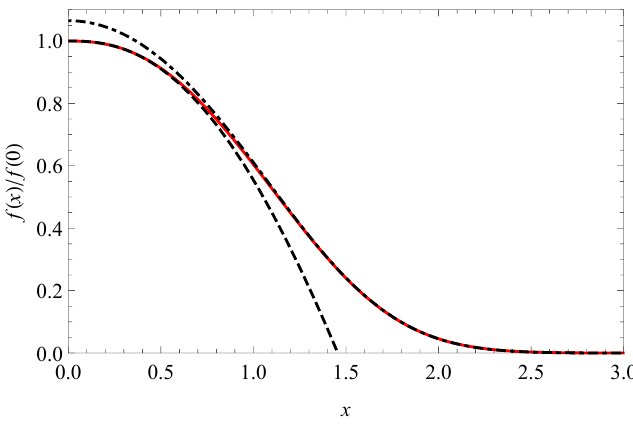
Figure 3: Red solid line: numerical solution to Eq. (17). Black dashed: low energy approximation, Eq. (20). Black dot-dashed: high energy approximation, Eq.